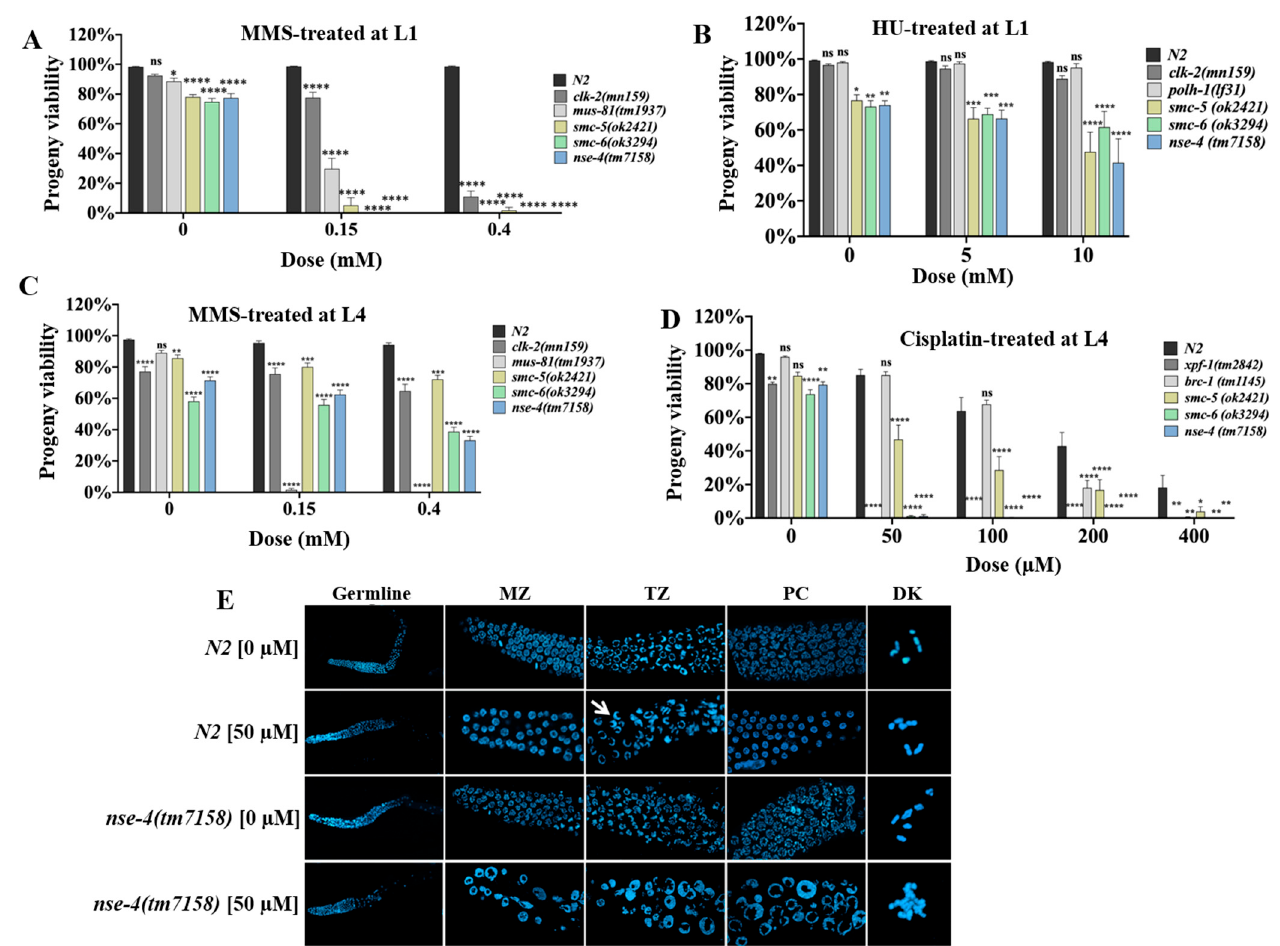
Figure 3. nse-4 is important for DNA repair. ( A ) Worm viability following exposure of L1 larvae to MMS at the indicated doses. ( B ) Worm viability following exposure of L1 larvae to HU at the indicated doses. ( C ) Worm viability following L4 stage worm exposure to MMS at the indicated doses. ( D ) Worm viability following L4 stage worm exposure to cisplatin at L4 stage. In all cases ( A – D ), viability was scored as the percentage of hatched eggs over the total number of eggs laid. Data rep- resents cumulative of three independent repeats. The bar graphs show the cumulative mean ± S.E.M of worm viability compared to wild-type (ns—not significant; * p < 0.05; ** p < 0.01; *** p < 0.001; **** p < 0.0001, Two-way ANOVA with Dunnett’s multiple comparisons test). ( E ) Germline micrograph of cisplatin-treated worms. Worms were treated at a dose of 50 μ M cisplatin for 16 h, allowed to recover on NGM plates for 24 h, and gonads were dissected and stained with DAPI. Germ cells are bloated and distorted, and the transition zone (white arrow) as well as chromosomal alignment at pachytene are absent in the cisplatin-treated nse-4(tm7158) . Whole germline (WG) was captured us- ing Zeiss confocal microscope LSM 800 at 10× (scale bar = 50 μ m); the other images were captured at 63× objective with oil immersion (scale bar = 10 μ m). MZ—mitotic zone, TZ—transition zone,